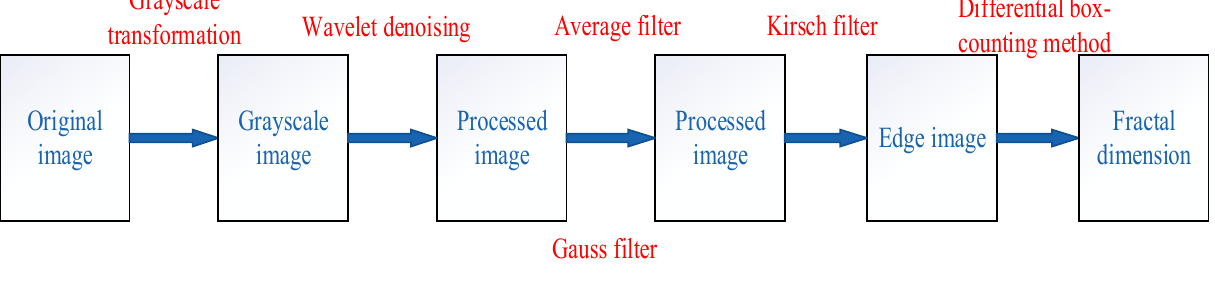
Figure 2. The flowchart of image-processing steps.